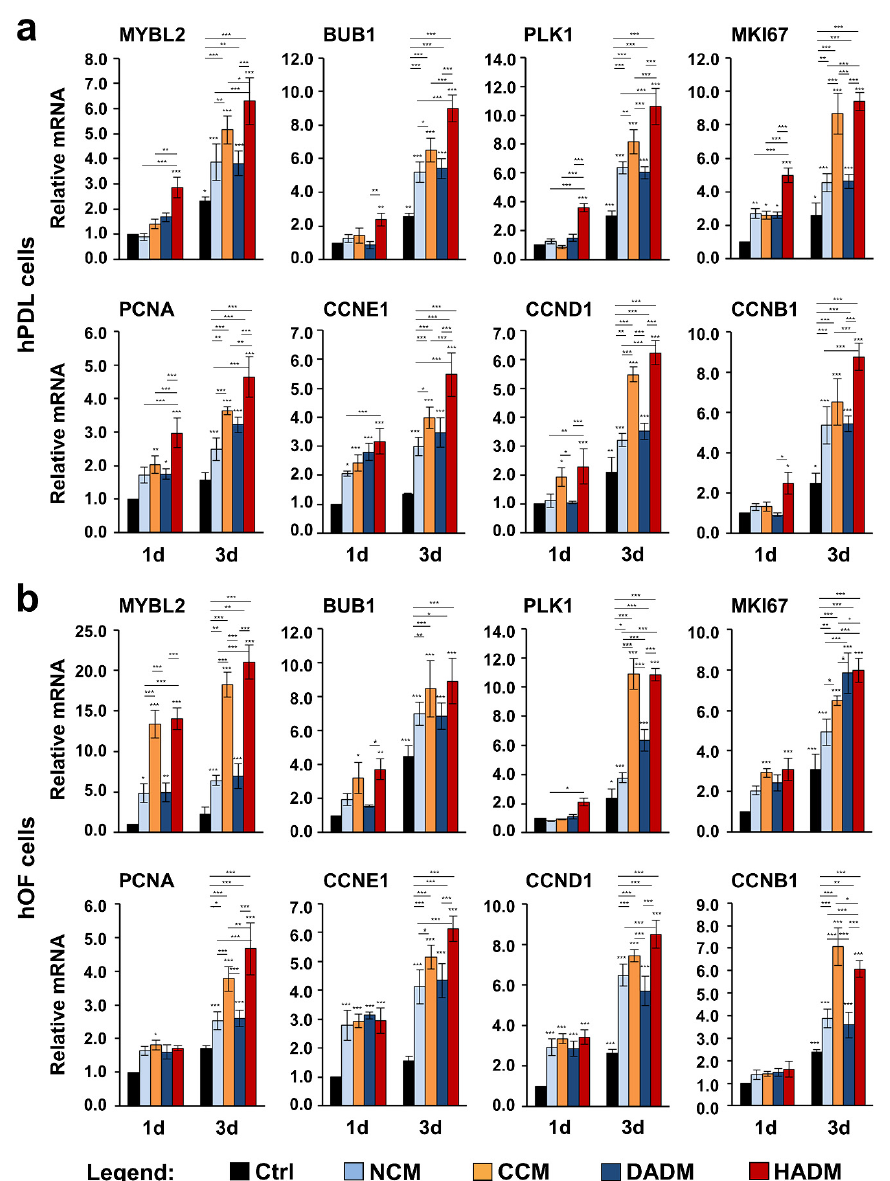
Figure 4. Increased expression of proliferative marker genes in two oral cell types cultured on four di ff erent collagen sca ff olds. hPDL ( a ) and hOF ( b ) cells were grown on four di ff erent collagen matrices (NCM, CCM, DADM, and HADM) for 1 and 3 days before total RNA was isolated and analyzed for the expression of proliferative marker genes (MYBL2, BUB1, PLK1, MKI67, PCNA, CCNE1, CCND1, and CCNB1) by qRT-PCR. Controls (Ctrl) represent cells of each cell type plated on cell culture plastic in the absence of a collagen matrix. Values normalized to GAPDH are expressed relative to the values of control cells at day 1 (1d). Data represent means ±SD from three independent experiments performed with three di ff erent cell donors for each of the two cell types. Significant di ff erences to the respective controls at day 1 unless otherwise indicated, *** p < 0.001, ** p < 0.01, * p <